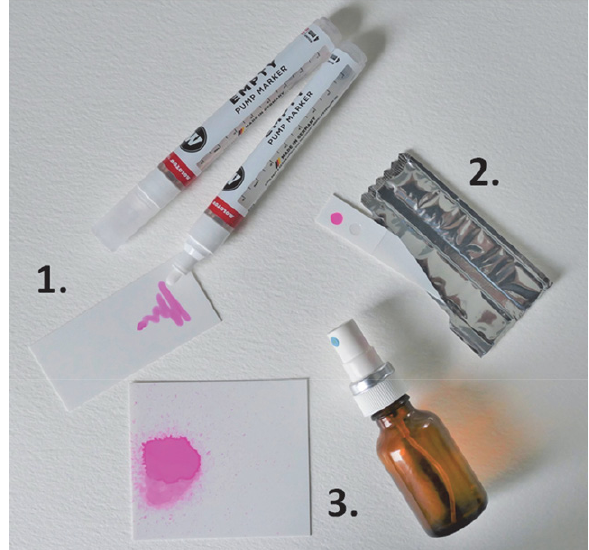
Figure 4: The proposed application utilises either the polymer solu- tion for the in-situ release of the detection films (1 – the detection marker, 3 – the detection spray) or the beforehand released film on the suitable carrier (2 – the test strip). The pink colouring was reached by the exposure of the detection devices to diphosgene va-